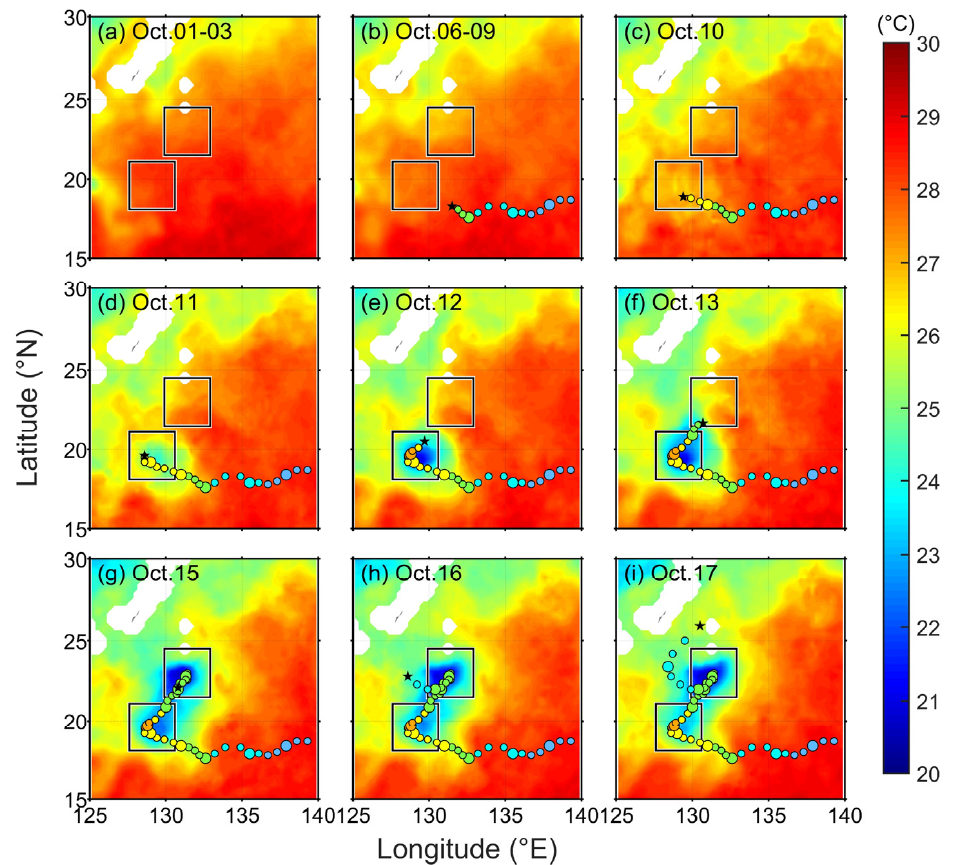
Figure 2. Spatial distribution of the sea surface temperature (SST) evolution before, during, and after the passage of Typhoon Prapiroon. ( a ) The pre-typhoon SST, averaged on 1–3 October; ( b ) the SST in the study area during Prapiroon, averaged on 6–9 October; ( c – f ) the SST in the study area during Prapiroon from 10 October to 13 October; and ( g – i ) the SST in the study area during Prapiroon from 15 October to 17 October. Two solid boxes are the two focused domains of the sudden-turning stages of the typhoon, denoted A1 and A2. The coloured lines and dots represent the track and intensity of the typhoon. The black star in each figure indicates the last position where the typhoon arrived on that day.